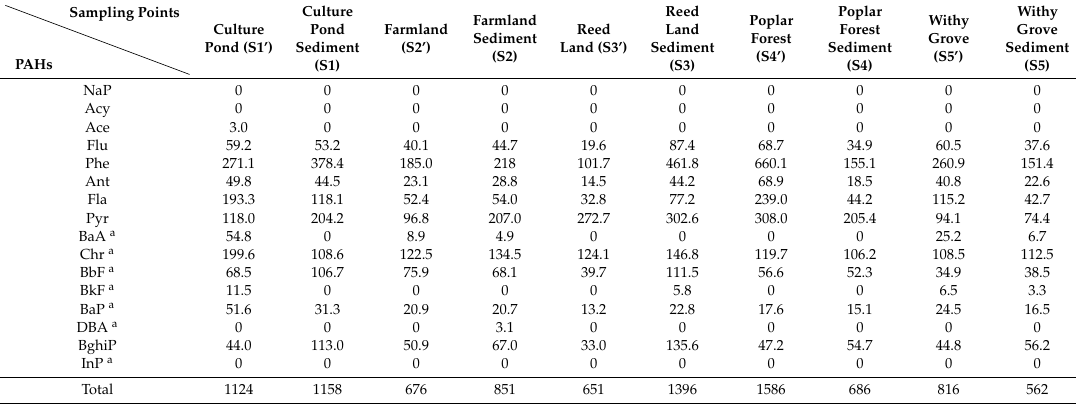
Table A3. The contents of 16 kinds of PAHs in the estuary of Hongze Lake (ng /